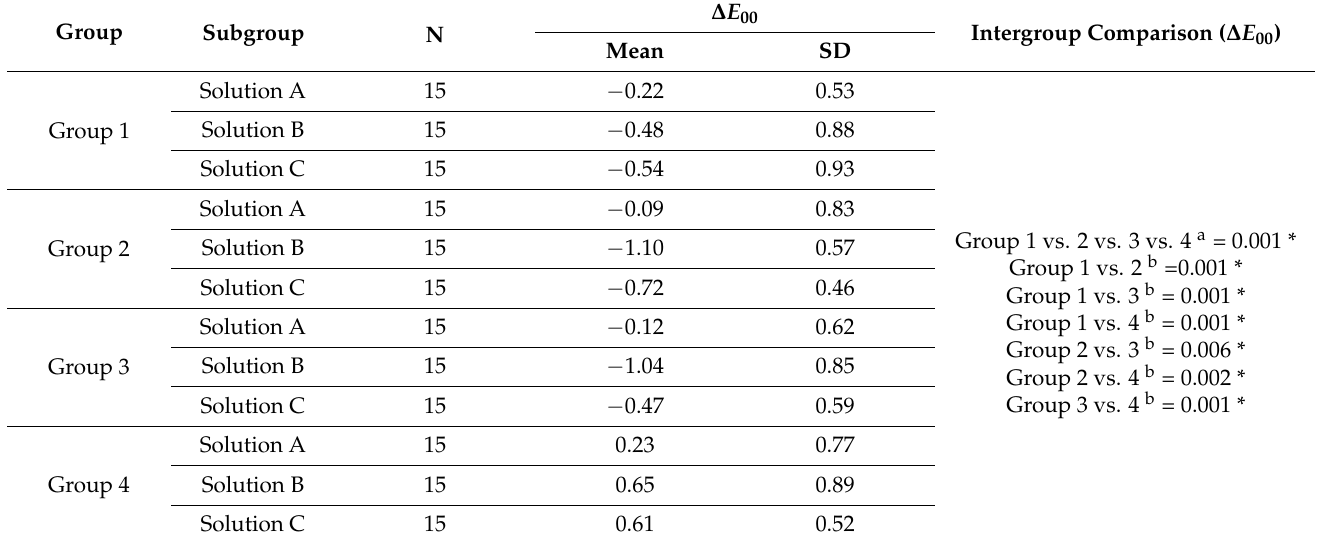
Table 2. Mean color change ( ∆ E 00 ) among the groups.